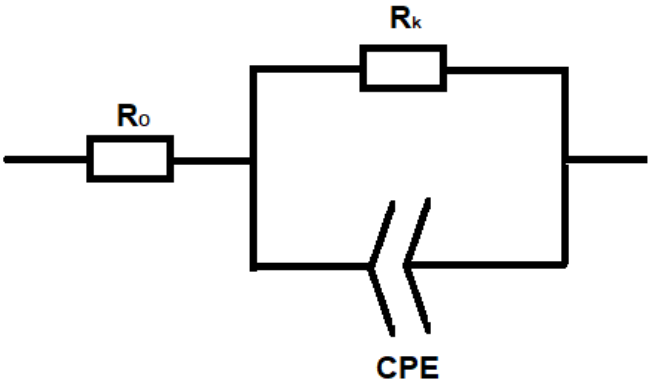
Figure 7. Nyquist plot of PEMFC for SFF and MSSFF.